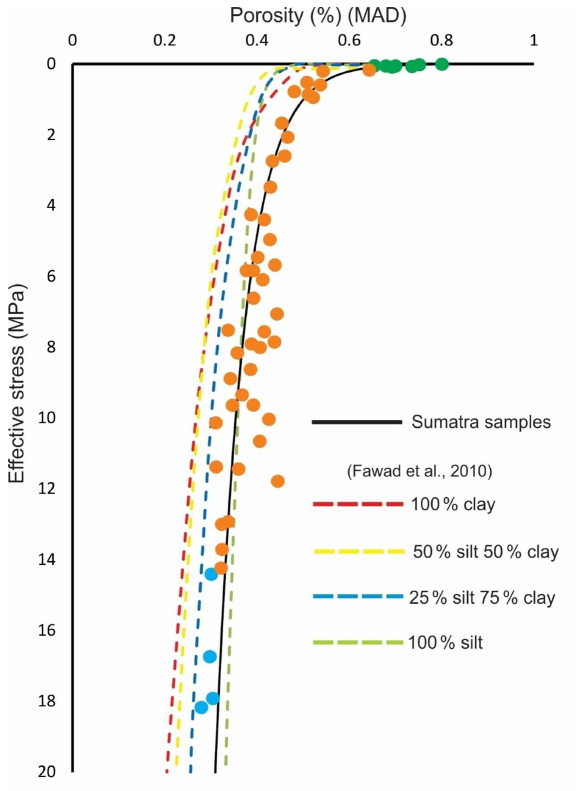
Figure 11. Effective stress vs. porosity (MAD) for experimen- tal mixtures of clay and silt (dashed lines; Fawad et al., 2010) compared with Sumatra data (Unit 1: green; Unit II: orange; Unit III: blue). The solid black solid line is a best-fit data regression for Sumatra samples.